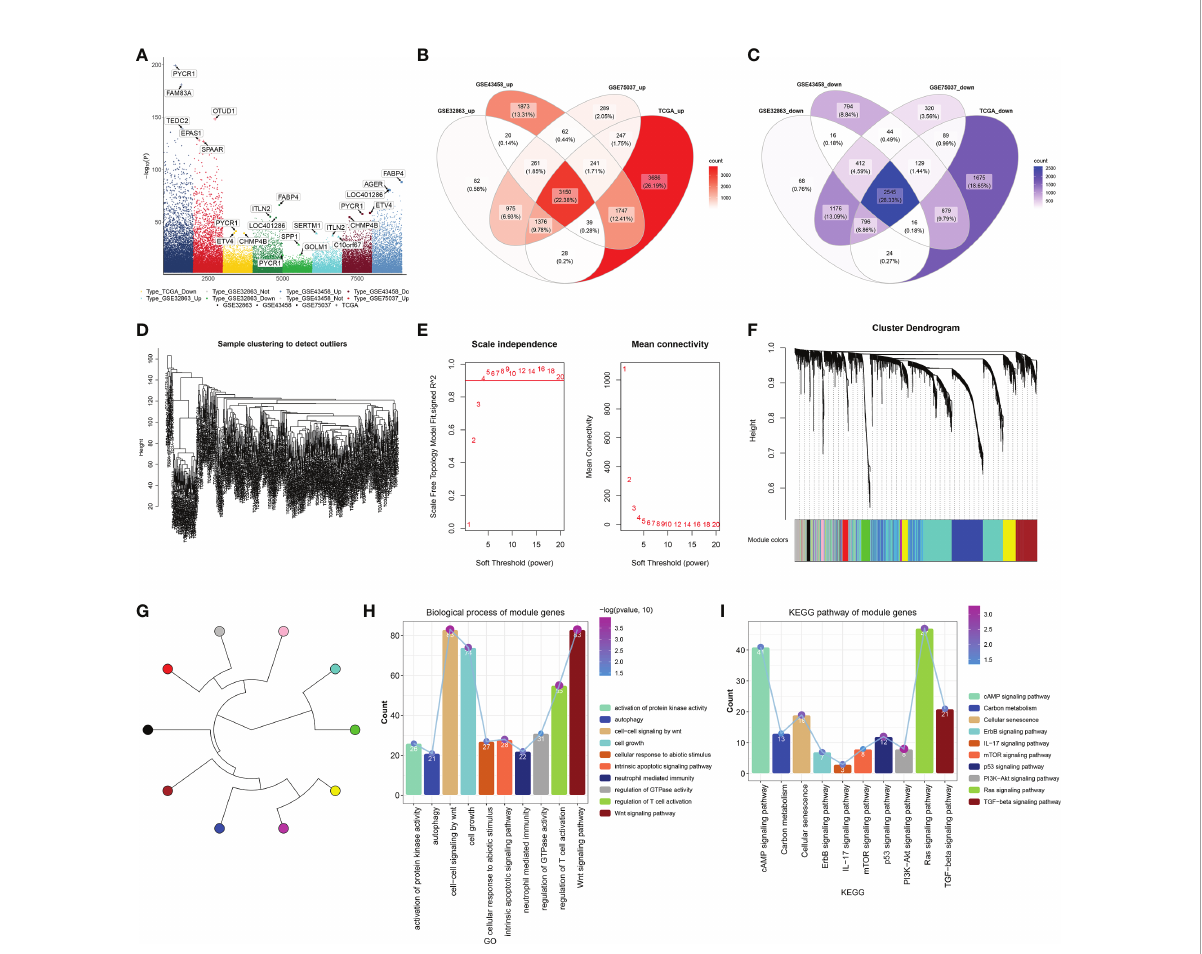
FIGURE 1 Identi fi cation of DEGs in LUAD and their co-expression modules. (A) Genes with notable upregulation or downregulation in LUAD than controls in four LUAD datasets (GSE32863, GSE43458, GSE75037, and TCGA-LUAD). (B, C) Venn diagrams of upregulated or downregulated genes shared by above four datasets. (D) Sample clustering to detect outliers. (E) Calculation of scale independence or mean connectivity under diverse soft ‐ thresholding power b values. (F) Co-expression modules based on DEGs shared by above four datasets with average linkage clustering. (G) Co-expression module clustering diagram. (H, I) Biological processes and KEGG pathways of module genes. DEGs, differentially expressed genes; LUAD, lung adenocarcinoma; KEGG, Kyoto Encyclopedia of Genes and